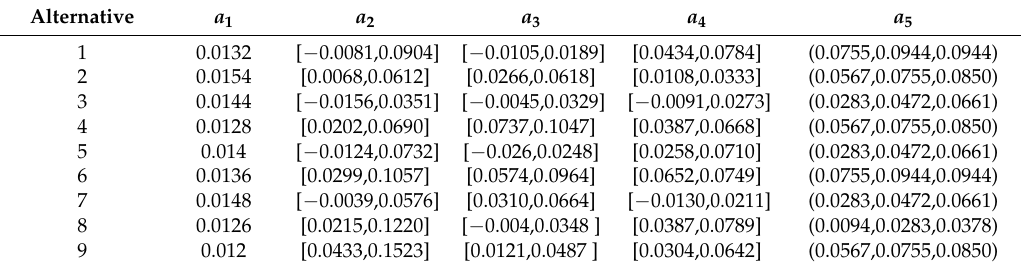
Table 5. Weighted normalized decision matrix.